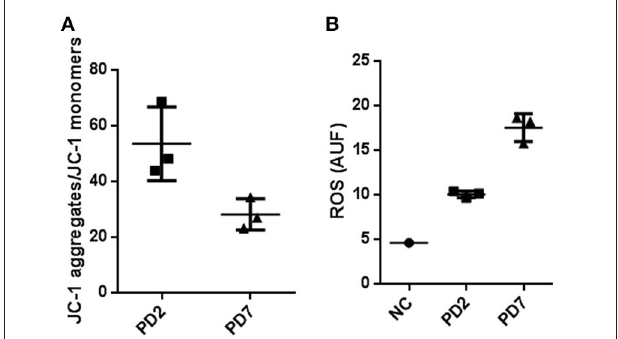
FIGURE 5 | Mitochondrial membrane potential and Reactive oxygen species production in young and senescent MSCs. (A) FACS analysis to determine membrane potential changes by means of JC-1, a lipophilic cationic dye selectively entering into mitochondria. JC-1 accumulation in mitochondria, due to concentration-dependent formation of red fluorescent JC-1 aggregates was higher for MSCs cultured up to PD2 compared with PD7 MSCs. Results are presented as JC-1 aggregates/JC-1 monomer (B) . Reactive oxygen species production in young and senescent MSCs was compared by Mitosox Red fluorescent intensity production quantified by flow cytometry and expressed as arbitrary units fluorescence ROS (AUF). As a positive control rotenone at 50 µ M was